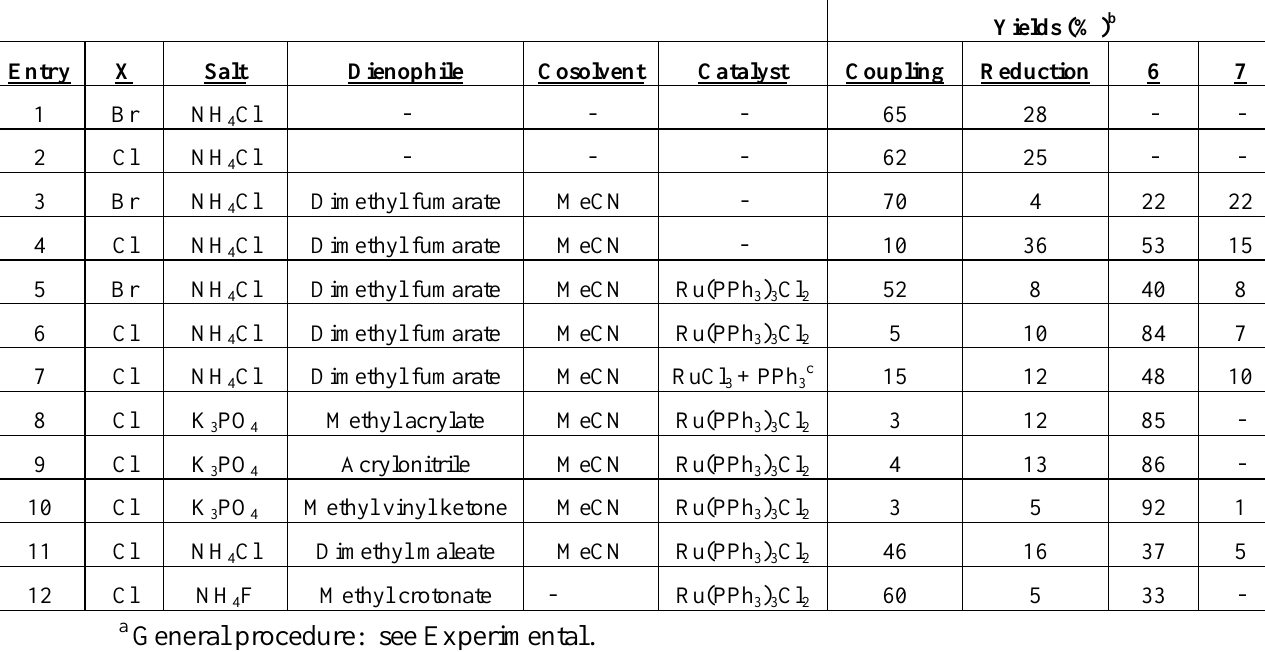
Table 1. Reactions of α,α '-dihalo-o-xylenes ( 1 ) and zinc in aqueous medium a